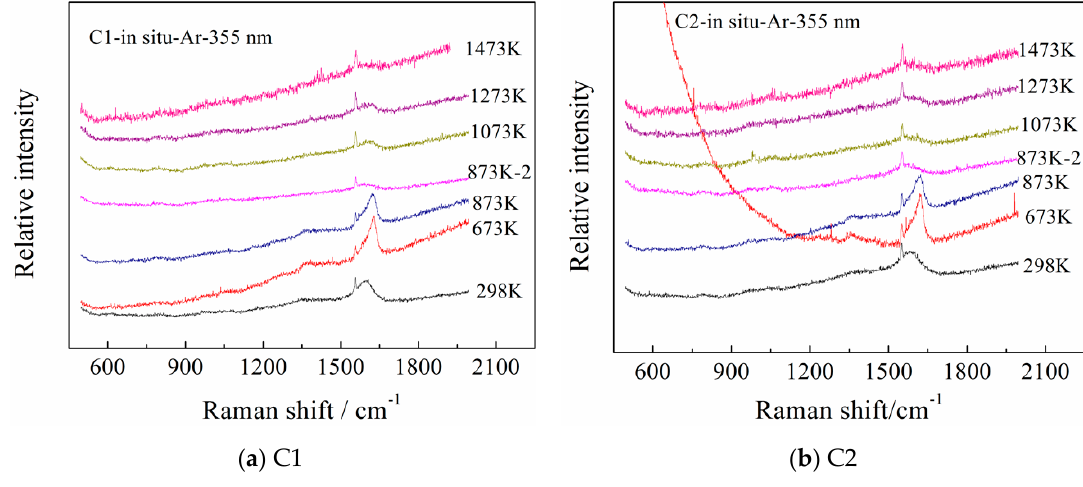
Figure 6. Temperature dependence of in-situ Raman spectra of C1 and C2 under an Ar atmosphere using a 355 nm excitation laser.